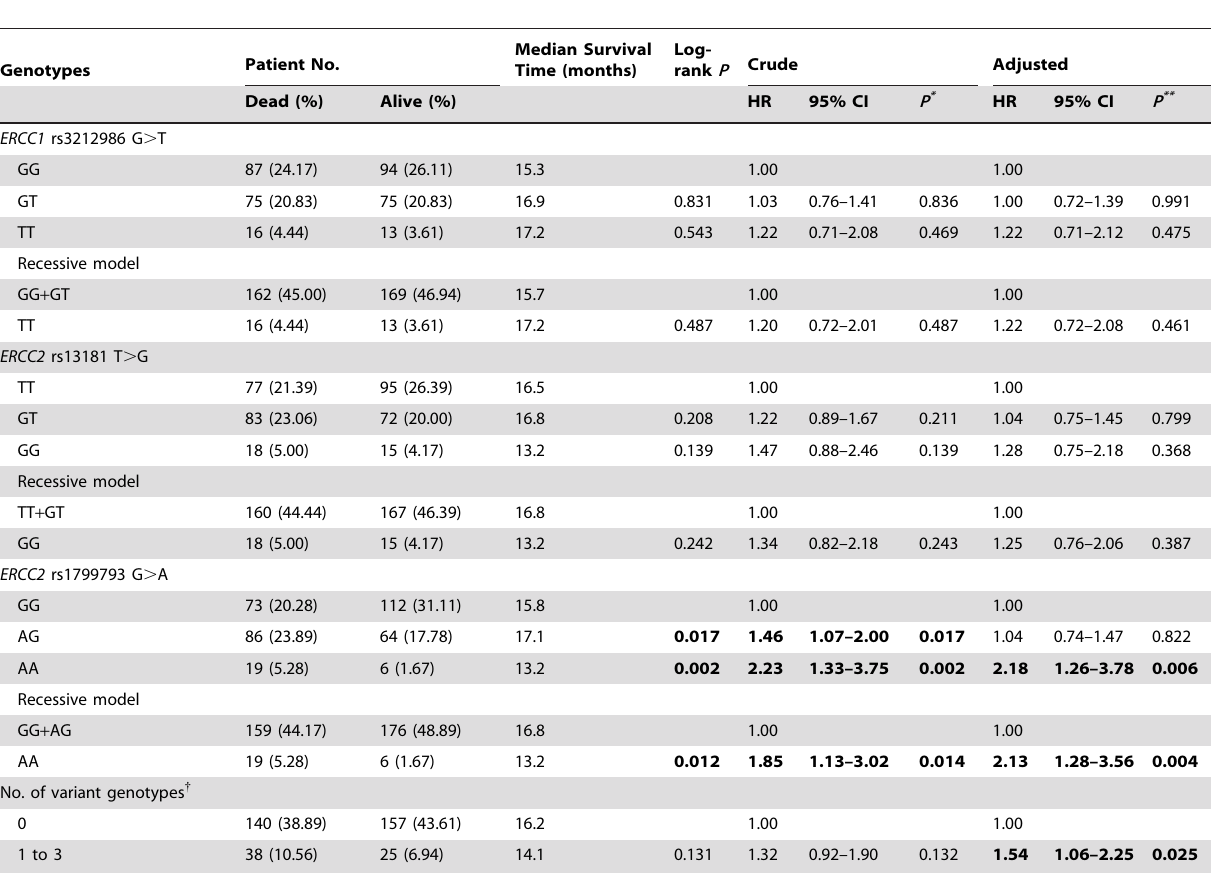
Table 2. Univariate and multivariate analyses of associations between ERCC1 genotype, ERCC2 genotypes, combined ERCC1 and ERCC2 variants and overall survival in gastric cancer